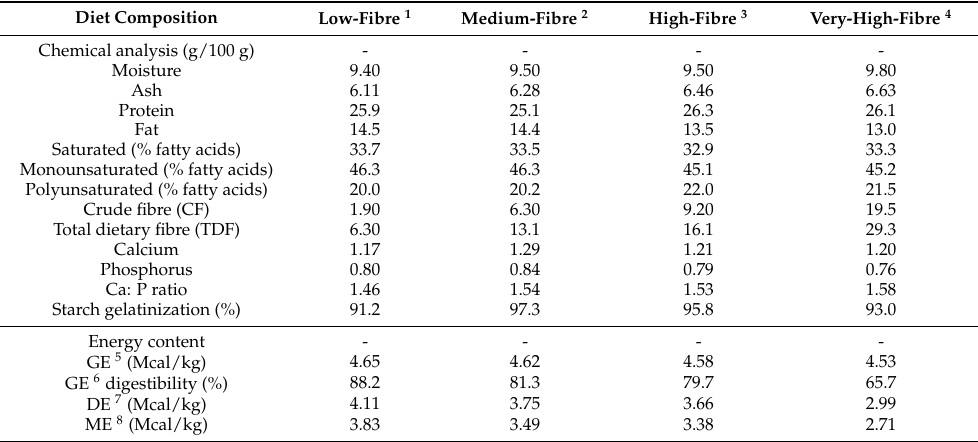
Table 1. Nutrient composition and energy content on as fed basis of the diets used in